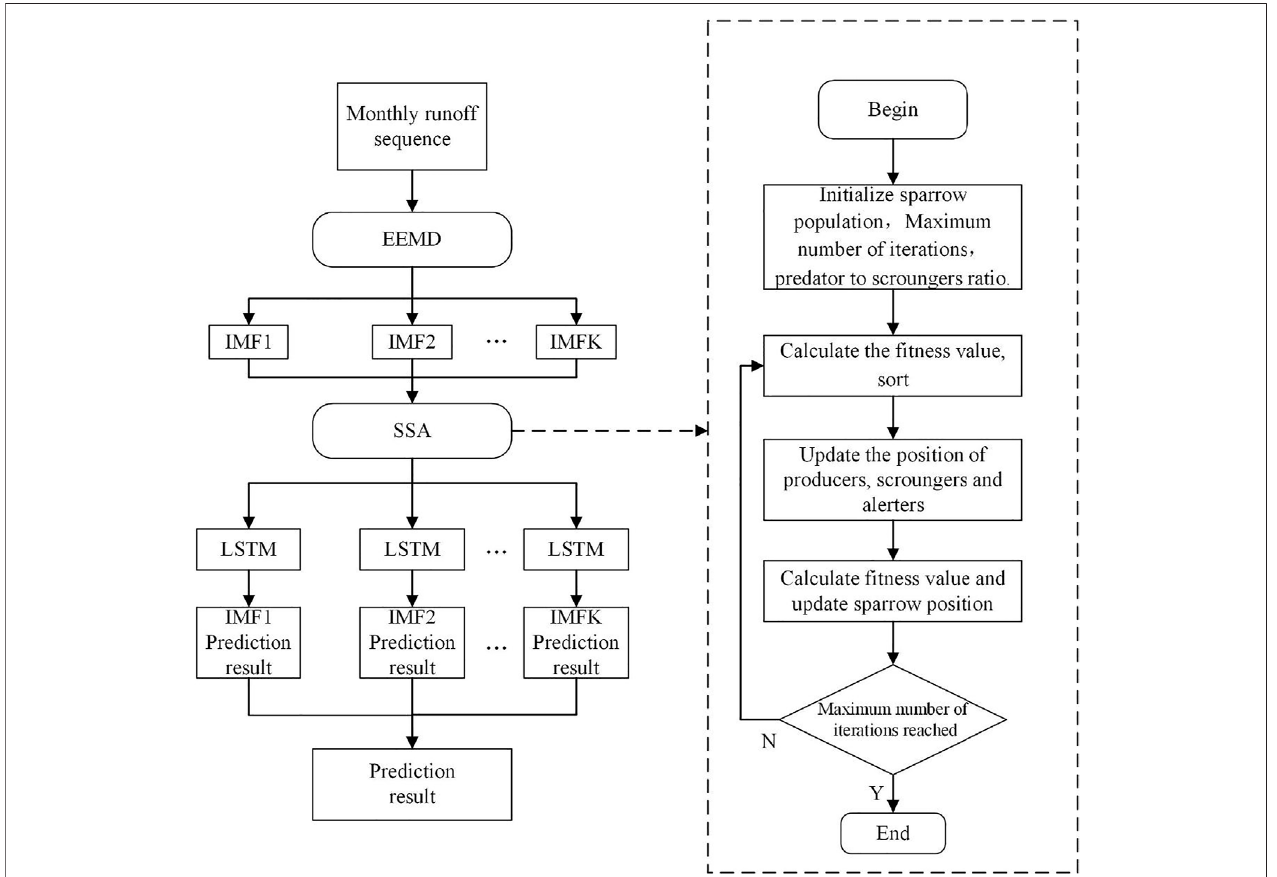
FIGURE 1 | Flowchart of EEMD-SSA-LSTM for monthly runoff forecasting.